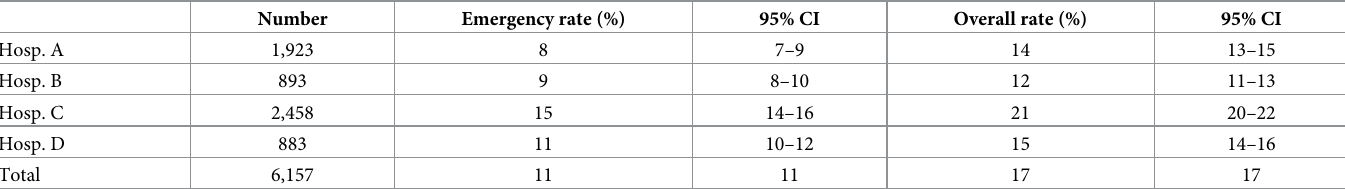
Table 2. Emergency and overall (scheduled and emergency) cesarean rates by hospital.